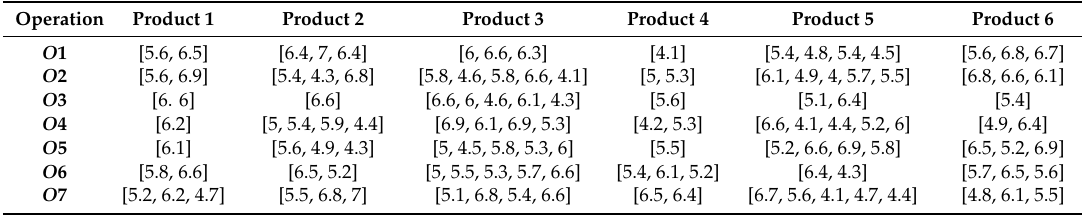
Table A1. Working power for the operations processed on machines in case